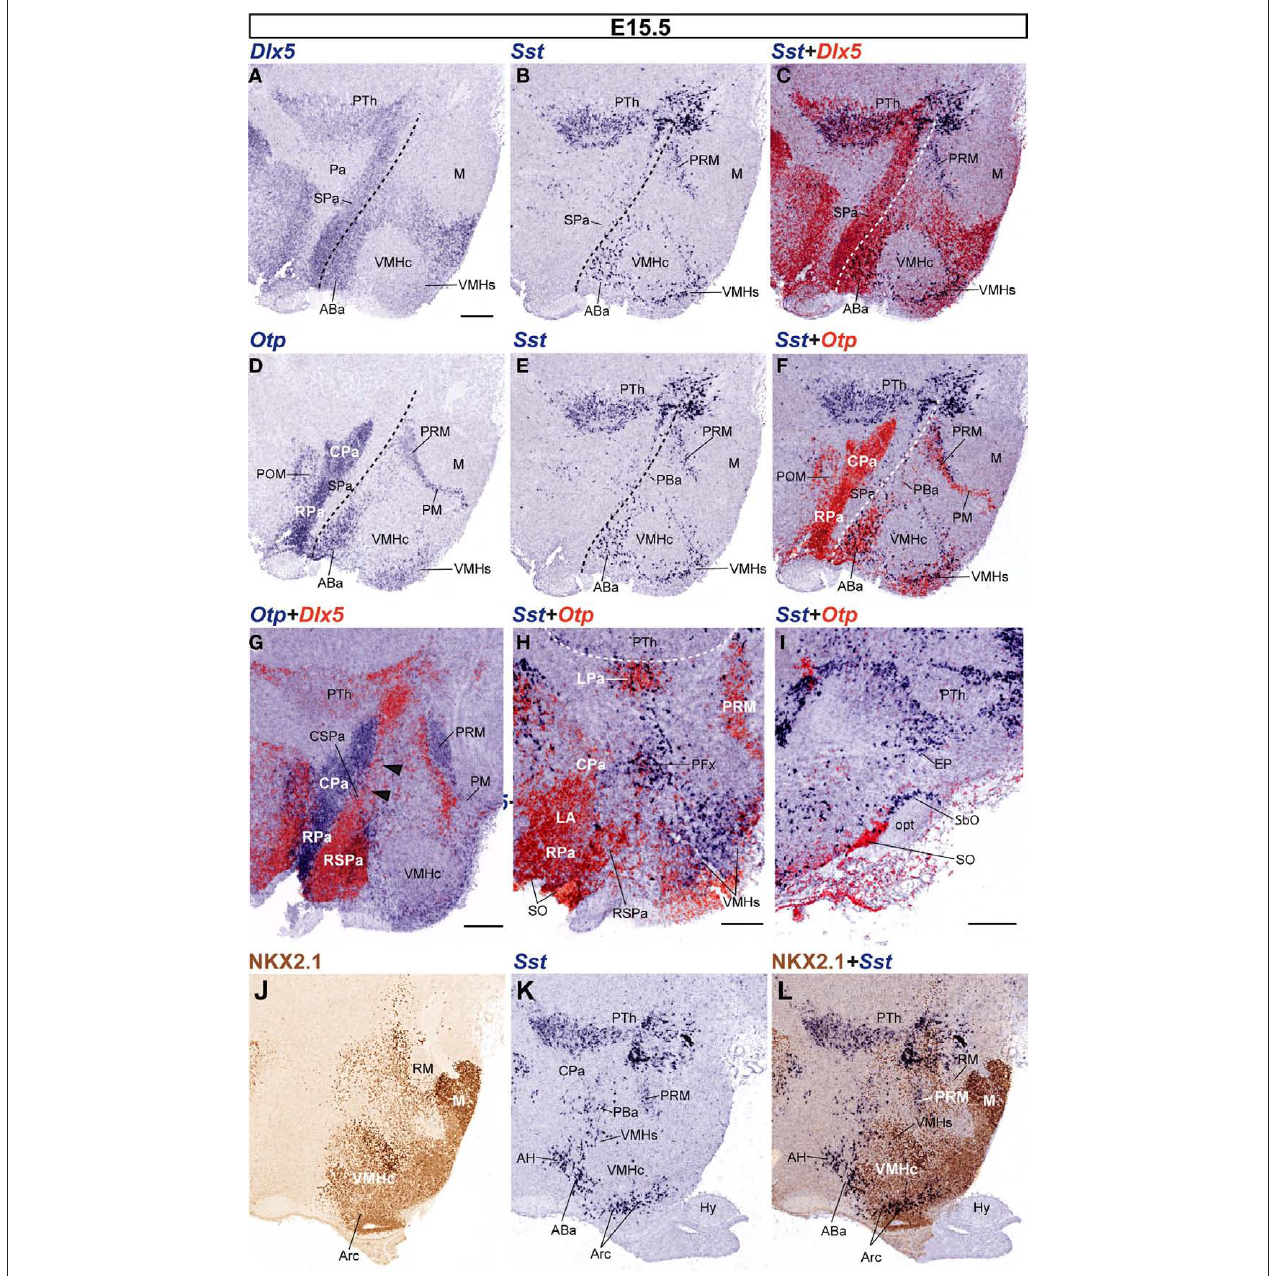
FIGure 6 | Sagittal sections of e15.5 embryos, correlating the indicated reference markers with the presence of Sst -positive cells in adjacent sections. (A–I) This series of sections is a medio-lateral progression, where (A–F) represent adjacent sections compared to each other by digital overlap (C,F) , and the analogous overlaps shown in (G–I) lie progressively more laterally. The dashed lines in (A–F) indicate the alar–basal boundary.